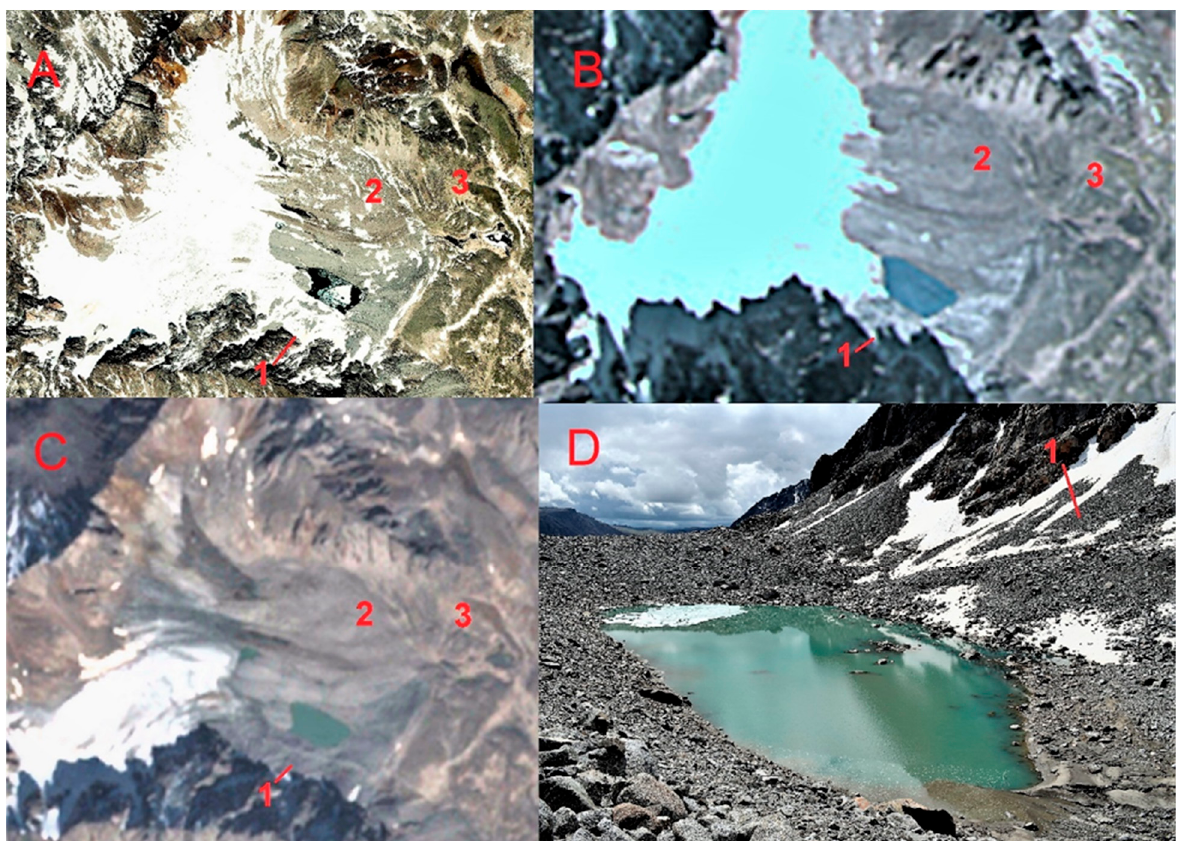
Figure 3. Identification of the LIA moraines and of the present edge of a glacier, Tolayty valley, Mongun-Taiga massif. ( A ) WorldView-2 image, 26 June 2015, ( B ) Spot-5 image, 19 September 2011, ( C ) Sentinel-2 image, 6 September 2016, ( D ) photo, 6 October 2019: 1—snow-covered talus and dead ice (false glacier edge), 2—LIA moraine, 3—pre-LIA late Holocene moraine, so-called “historic” stage.